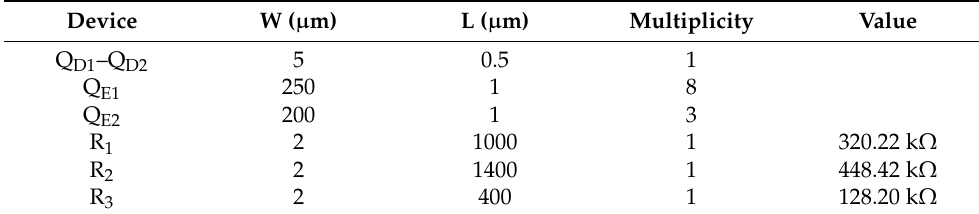
Table 2. Transistor dimensions and resistor values of the proposed voltage reference circuit. Device W ( µ m) L ( µ m) Multiplicity Value Q D1 –Q